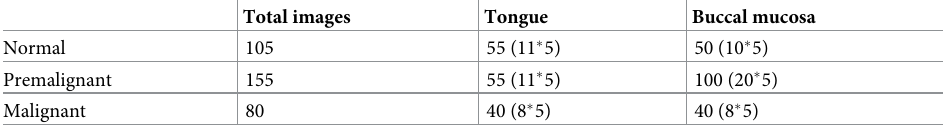
Table 1. Total fluorescence images studied under VELscope.